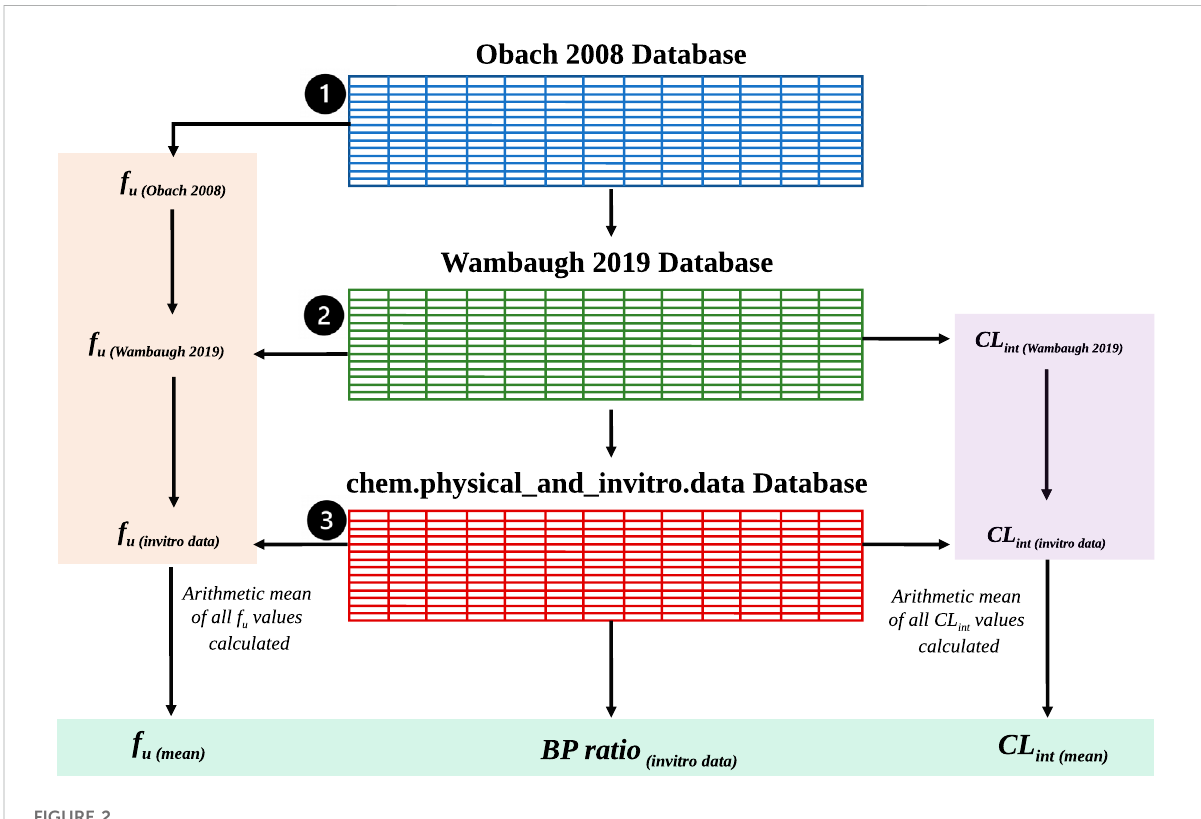
FIGURE 2 An exemplar data collection and processing work fl ow where users chose to use the three httk -R package databases to extract BP ratio and computethearithmeticmeansof CL int and f u .Shadedingreenarethe fi nalparameteroutputsfromthe httk databaseswhichwillbeusedforSimcyp ®